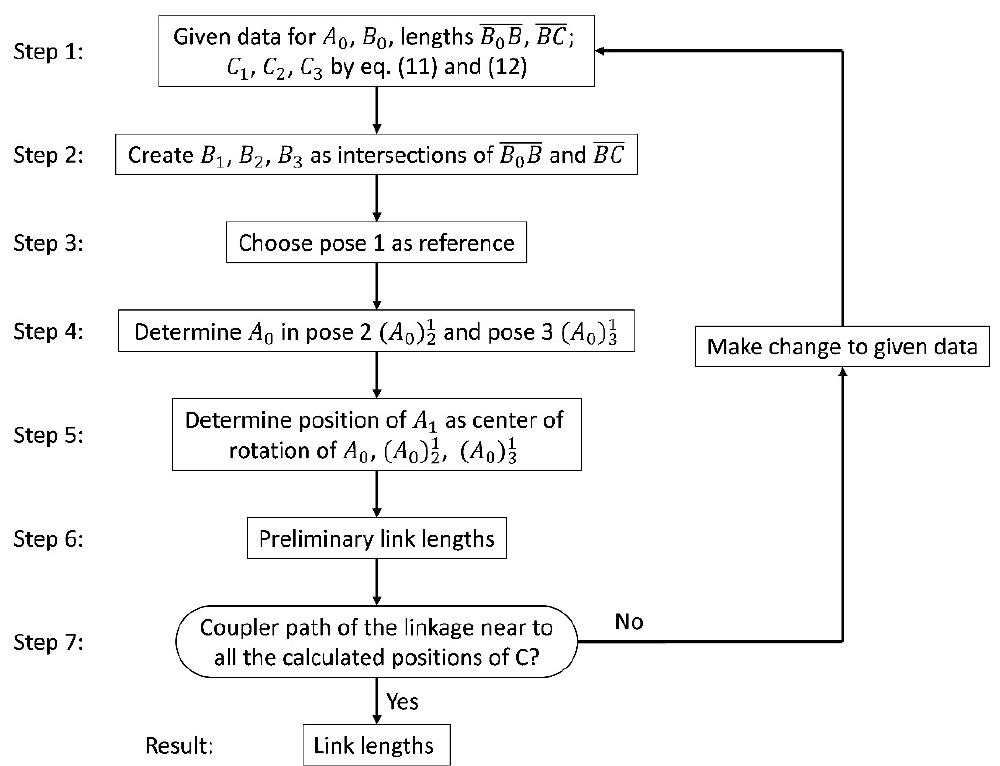
Figure 9. Schemes for a dimensional synthesis: ( a ) the problem to be solved; ( b ) graphical solution as based on the approach that is described in [33].